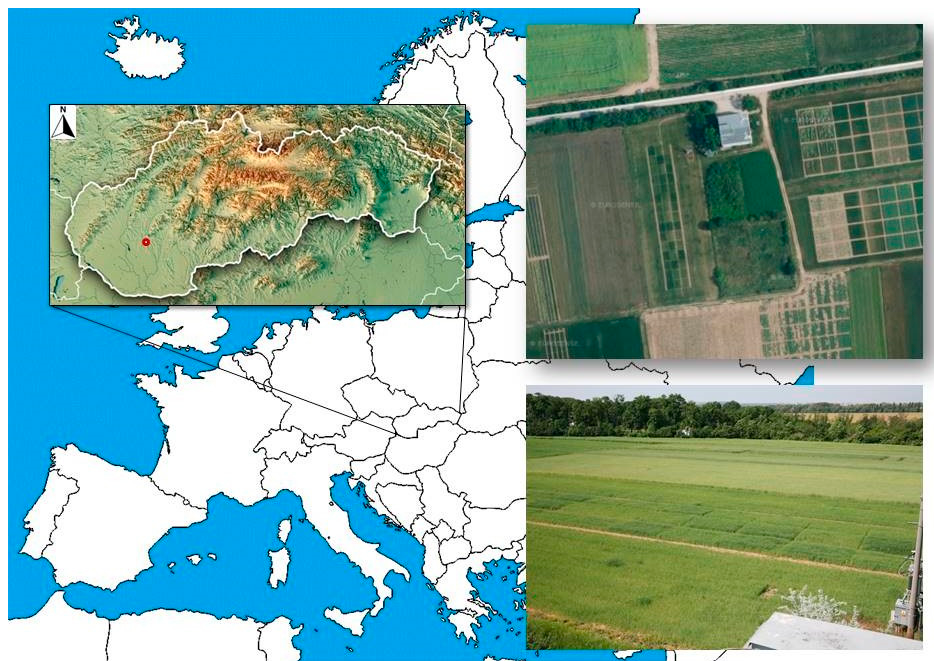
Figure 1. Experimental site location.